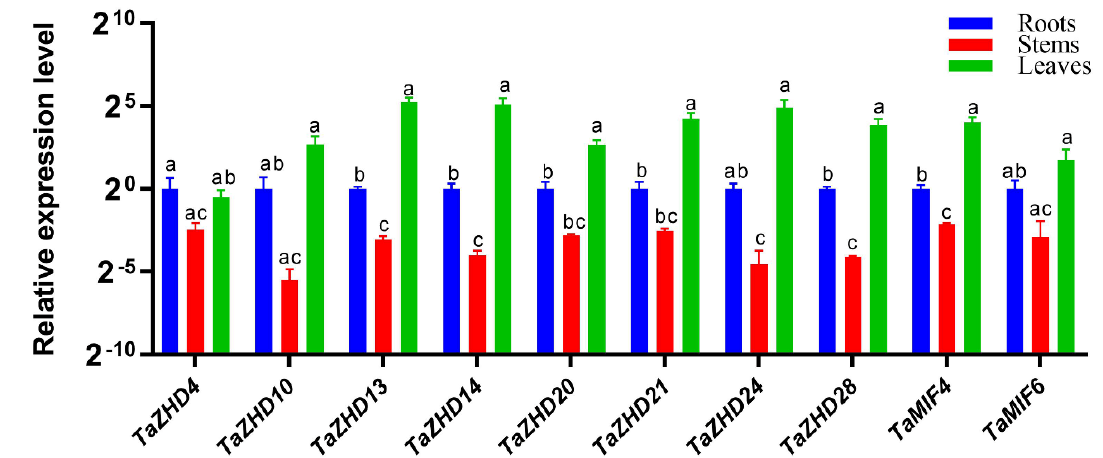
mean ± SE from three samples. Statistical significance was determined by a student’s t -test and different lowercase letters indicate significant differences ( p < 0.05) for each parameter.